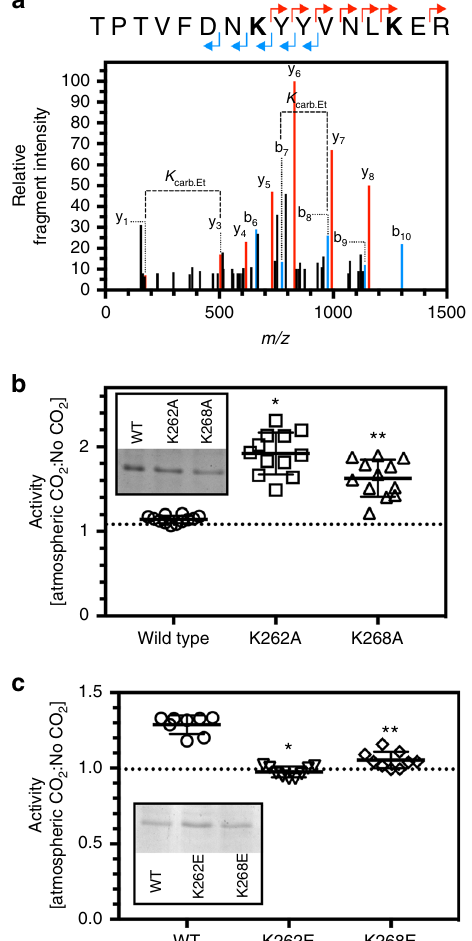
Fig. 8 Biochemical validation of At PRX34 as a carbamylated protein. a MSMS spectra of peptides containing ethyl-trapped carbamates on Lys 262 and Lys 268 of At3g49120. The peptide sequences above the panel indicate the assignment of predominantly singly charged y (red) and b (blue) ions. The modi fi ed residue is indicated in bold. K carb.Et indicates the molecular weight difference between ions diagnostic of the modi fi ed Lys. b The ratios of the speci fi c activities of wild type, K262A or K268A At PRX34 protein at atmospheric CO 2 or in the absence of CO 2 (* p < 0.0001 compared to wild type, one-way ANOVA with Dunn Bonferroni multiple comparison test, n = 12 independent replicates, Kruskal – Wallis statistic = 26.4, ±S.D.; ** p < 0.0028 compared to wild type, one-way ANOVA with Dunn Bonferroni multiple comparison test, n = 12 independent replicates, Kruskal-Wallis statistic = 26.4, ±S.D.). Inset — puri fi cation of recombinant At PRX34 proteins (1.0 μ g; SDS/PAGE analysis and Coomassie Blue staining). c The ratios of the speci fi c activities of wild type, K262E or K268E At PRX34 protein at atmospheric CO p < 2 or in the absence of CO 2 (* 0.0001 compared to wild type, one-way ANOVA with Dunn Bonferroni multiple comparison test, n = 9 independent replicates, Kruskal – Wallis statistic = 19.53, ±S.D.; ** p < 0.0194 compared to wild type, one-way ANOVA with Dunn Bonferroni multiple comparison test, n = 9 independent replicates, Kruskal – Wallis statistic = 19.53, ±S.D.). Inset- Puri fi cation